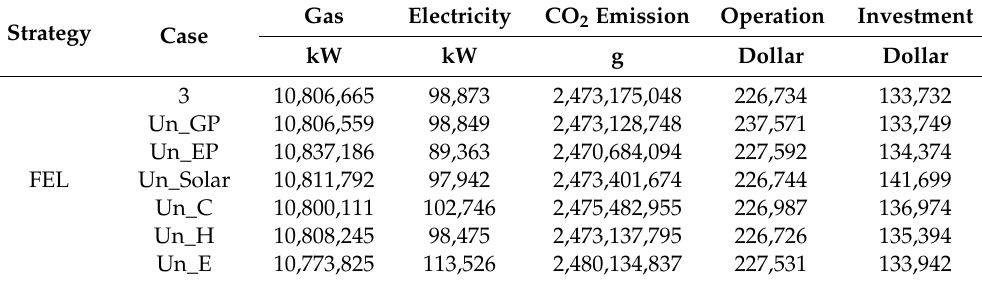
Table 9. Operation and costs under case 3 and the single uncertain